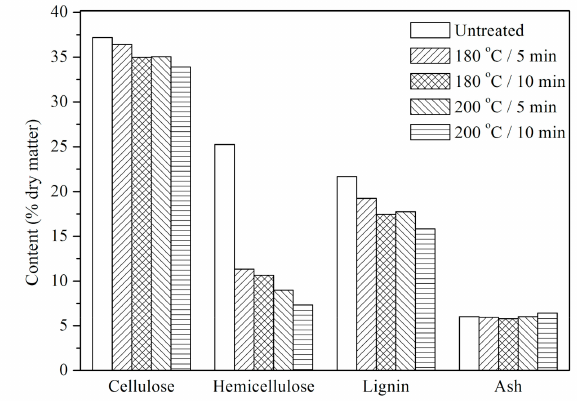
Figure 1. Main organic and ash composition of rice straws under di ff erent treatment conditions.